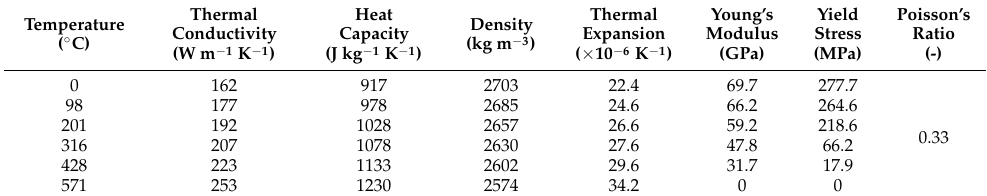
Table 10. Material properties of Al 6061 T6.